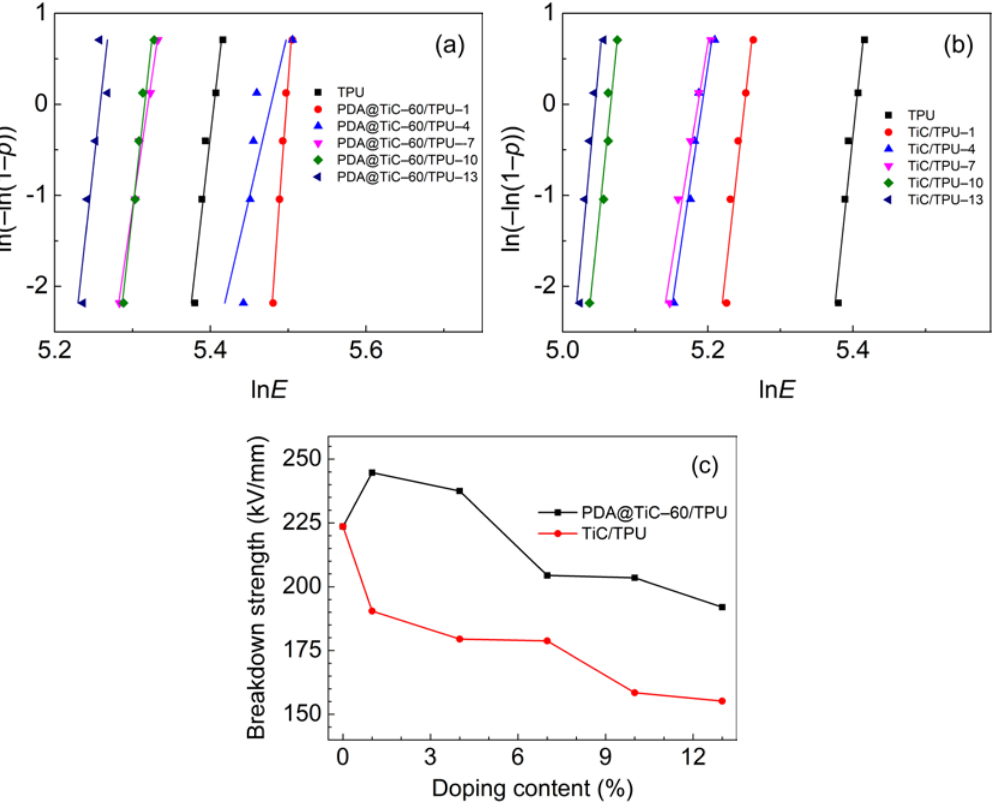
Figure 8. Weibull plots of PDA@TiC − 60/TPU ( a ) and TiC/TPU ( b ) and the breakdown strength of PDA@TiC − 60/TPU and TiC/TPU with different weight loadings of fillers ( c ).